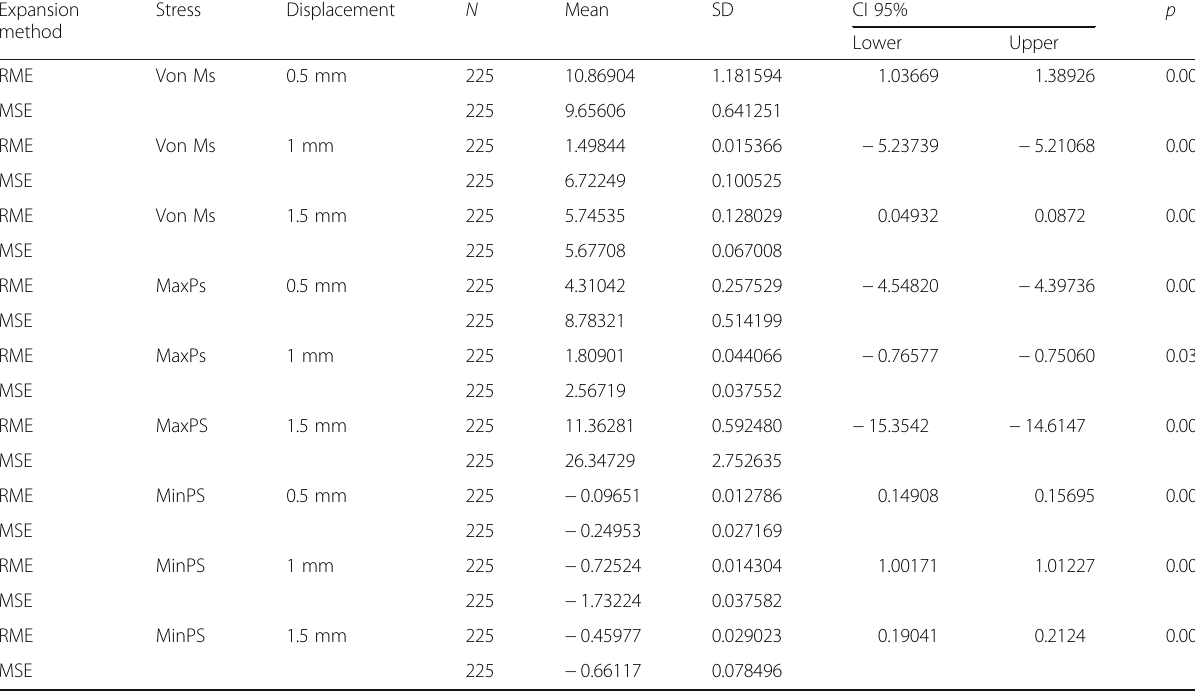
Table 2 Independent t test of the nodes on various displacement of expansion using RME and MSE (region of interest: upper first molar) Expansion